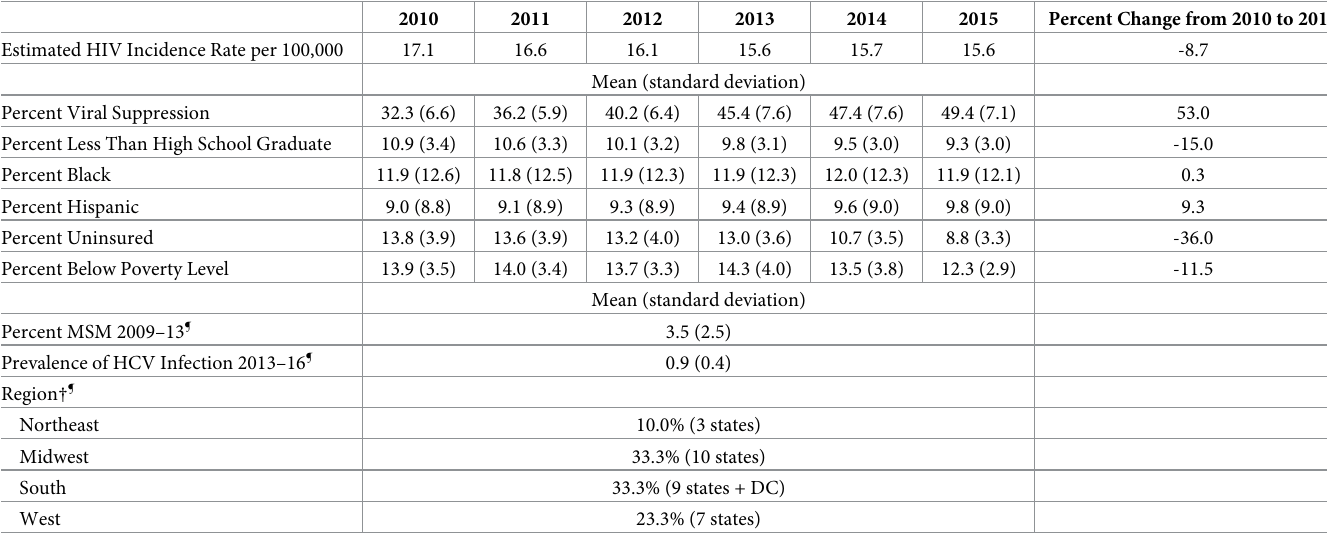
Table 1. Estimated HIV incidence rate, state level viral suppression and demographics by year for 29 states and the District of Columbia �